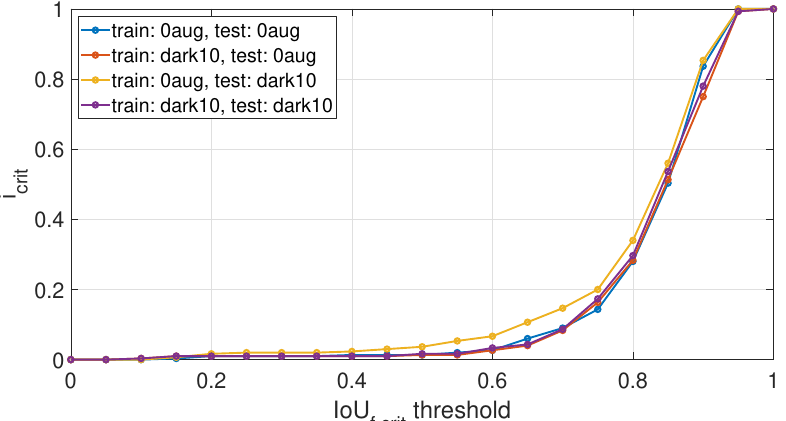
Figure 7. i crit Curves over incremental thresholds for DeepLabv3+ RN50, for instance, segmentation at different augmentation scenarios. We sample i crit at 21 IoU f,crit levels from 0.0 to 1.0. At increasing IoU f,crit , the fraction of critical Images i crit rises, resulting in a characteristic curve. The different curves visualize different augmentation scenarios for the network DeepLabv3+